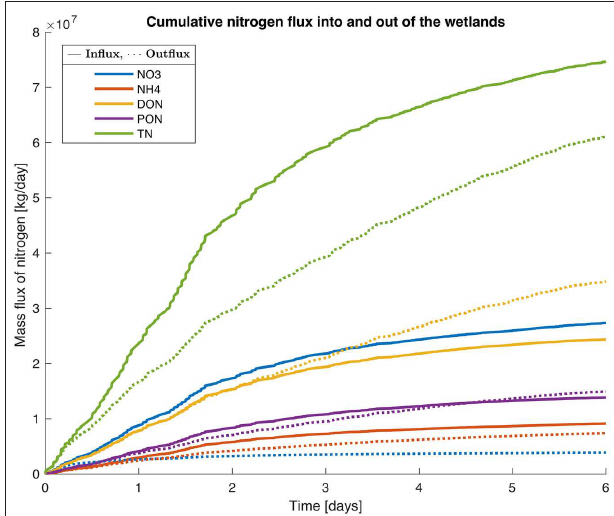
FIGURE 5 | Simulation of N conversion (NO − 3 , NH + 4 , DON, PON, and TN) within a wetland during a flooding event for 6 days on 28 March 2018. The model was run for a sub-catchment in the mouth of the Murray River (SC 187, see Figure 4C ), with an area of flooded wetlands of 2,213 ha, a peak volume of water of 51,000ML. Total N inputs during the flooding event for the sub-catchment were 62.2t DIN, 42.4t DON, 24.5t PON and 5,183t of suspended